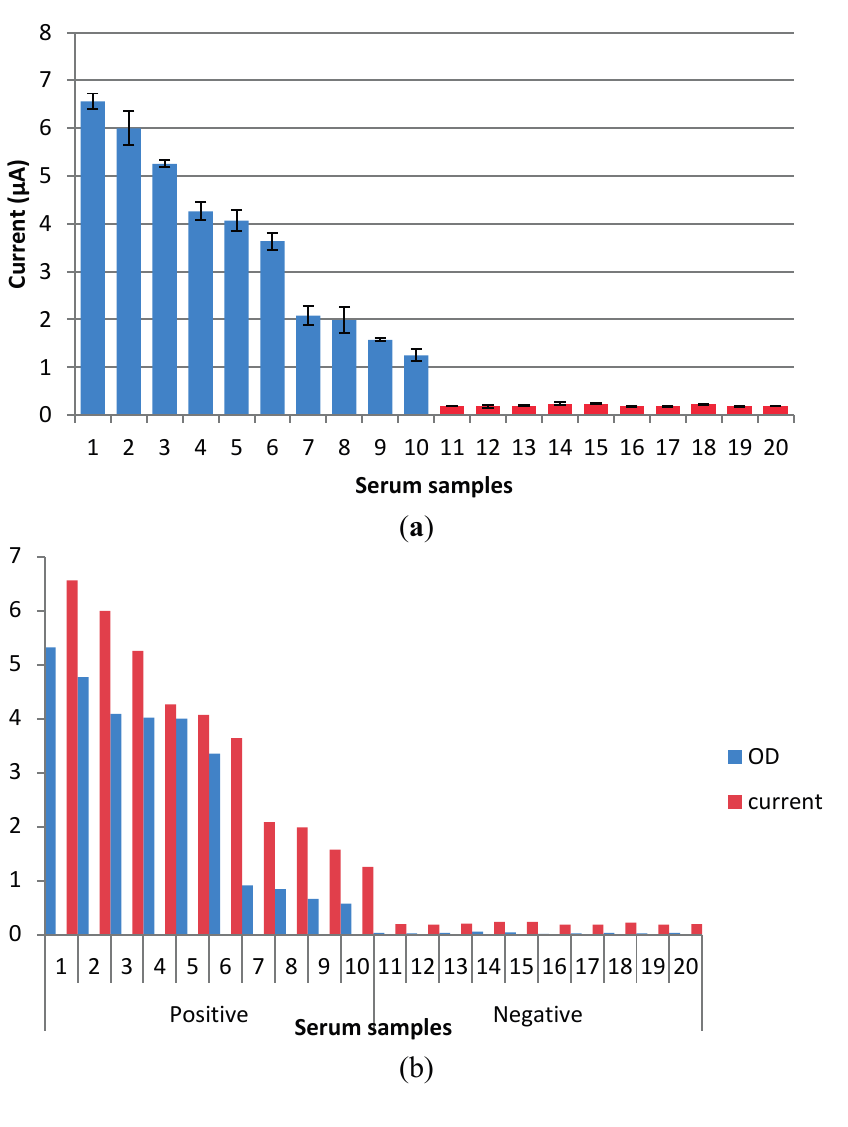
Figure 11. ( a ) Dengue NS1 detection in real samples; ( b ) Comparative analysis of dengue NS1 serum samples performed with Panbio ELISA kit and